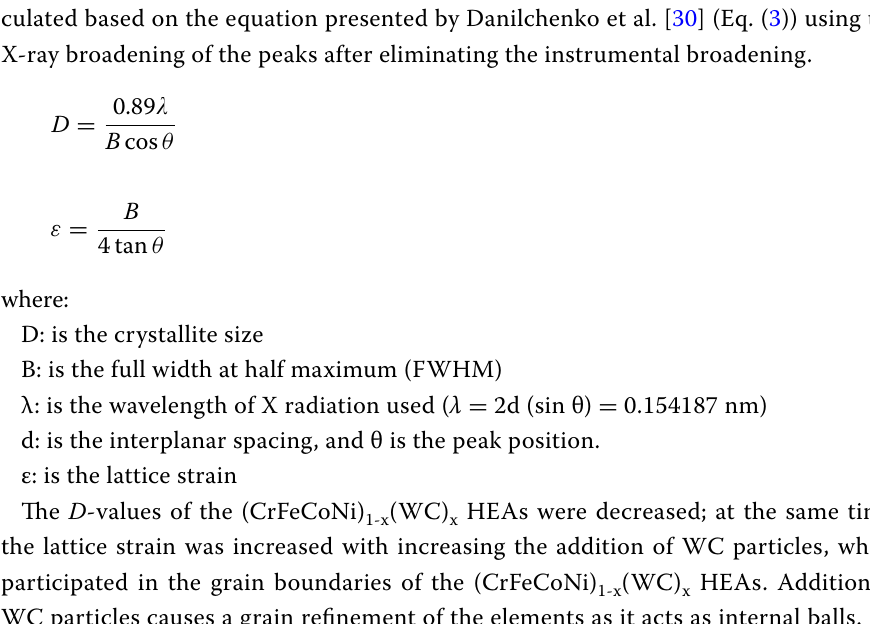
Table 2 Crystallite size (D) and lattice strain (ε) of (CrFeCoNi) composites